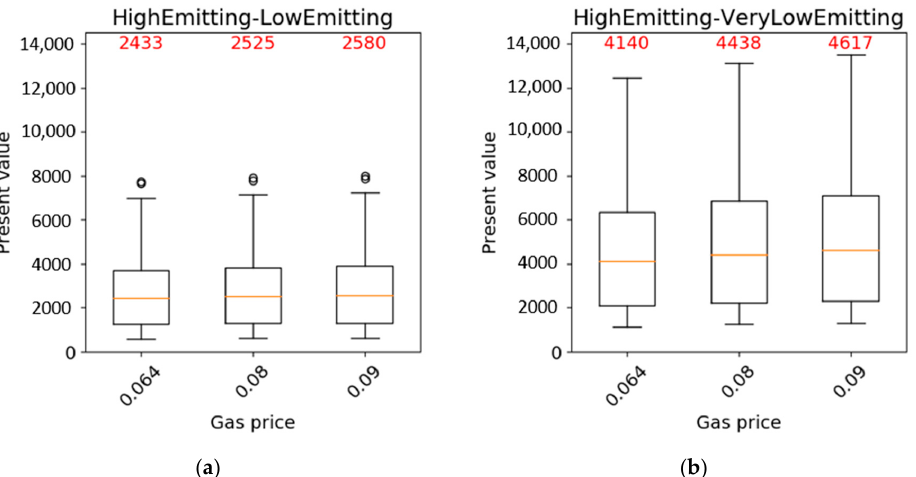
Figure 4. Present values calculated with different gas prices. ( a ) Scenario HE − LE. ( b ) Scenario HE − VLE.